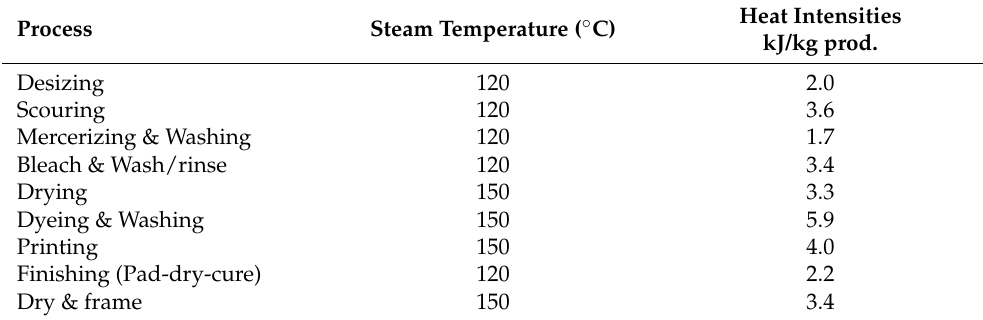
Table 1. Typical process steam temperatures for industrial heat pump applications (Data source [17] ).